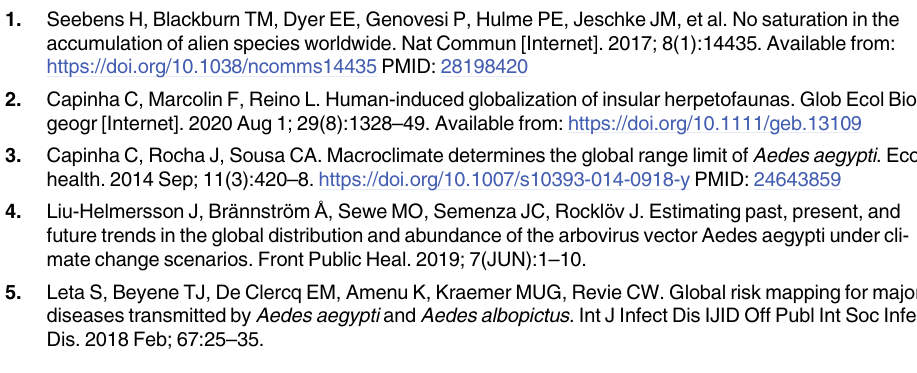
S8 Fig. Predictions obtained for the distinct modelling algorithms based on climatic condi- tions projected for the mid of the 21st century (2041–2060) under RCP4.5 BRT(a), GAM (b), GLM (c) an RF (d) (source of shapefile: https://www.dgterritorio.gov.pt/cartografia/ cartografia-tematica/caop). (TIF) S9 Fig. Predictions obtained for the distinct modelling algorithms based on climatic condi- tions projected for the mid of the 21st century (2041–2060) under RCP8.5 BRT(a), GAM (b), GLM (c) an RF (d) (source of shapefile: https://www.dgterritorio.gov.pt/cartografia/ cartografia-tematica/caop). (TIF) S10 Fig. Predictions obtained for the distinct modelling algorithms based on land use and human settlement conditions (source of shapefile: https://www.dgterritorio.gov.pt/ cartografia/cartografia-tematica/caop).